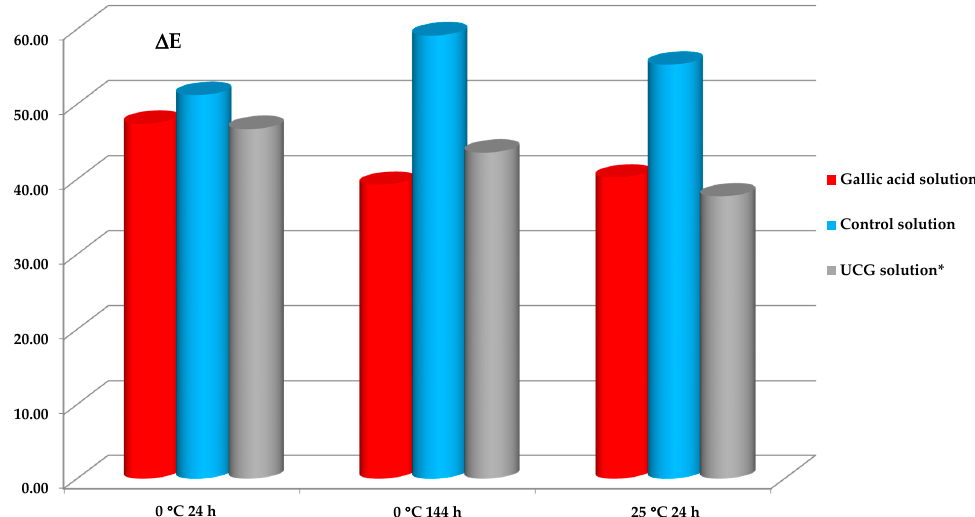
Figure 1. Total color difference ( ∆ E) to evaluate the anti-browning potential of the solutions. * Solution with the same concentration in terms of